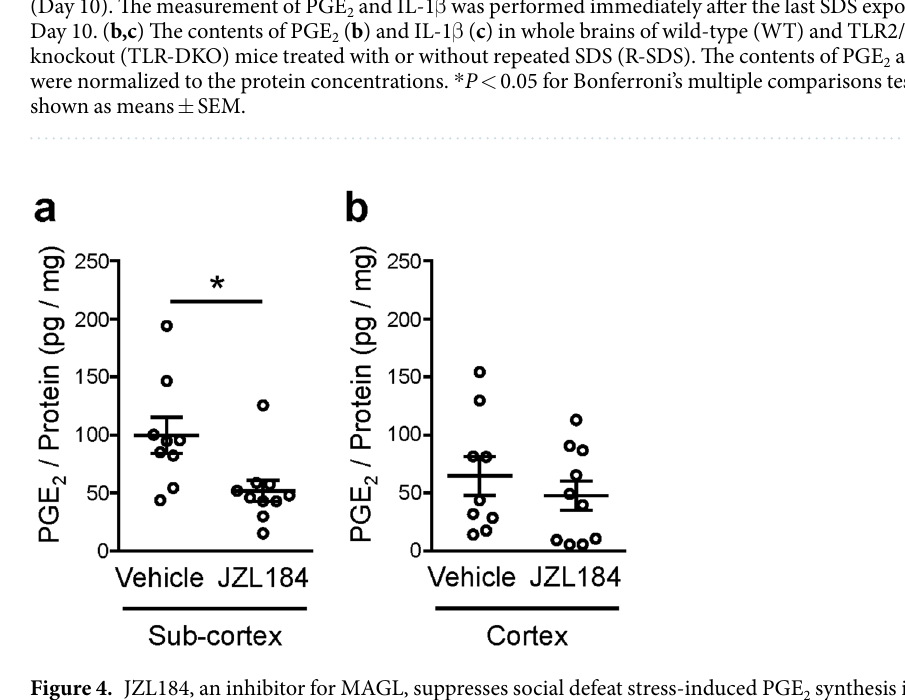
Figure 4. JZL184, an inhibitor for MAGL, suppresses social defeat stress-induced PGE 2 synthesis in subcortical tissues. The PGE 2 contents in subcortical ( a ) and cortical ( b ) tissues of wild-type mice treated with vehicle or JZL184 (40 mg/kg, i.p.) at least 60 min prior to single SDS. Brains were obtained immediately after single SDS and subjected to the PGE 2 measurement. * P < 0.05 for unpaired t test. Da t a are shown as means ±